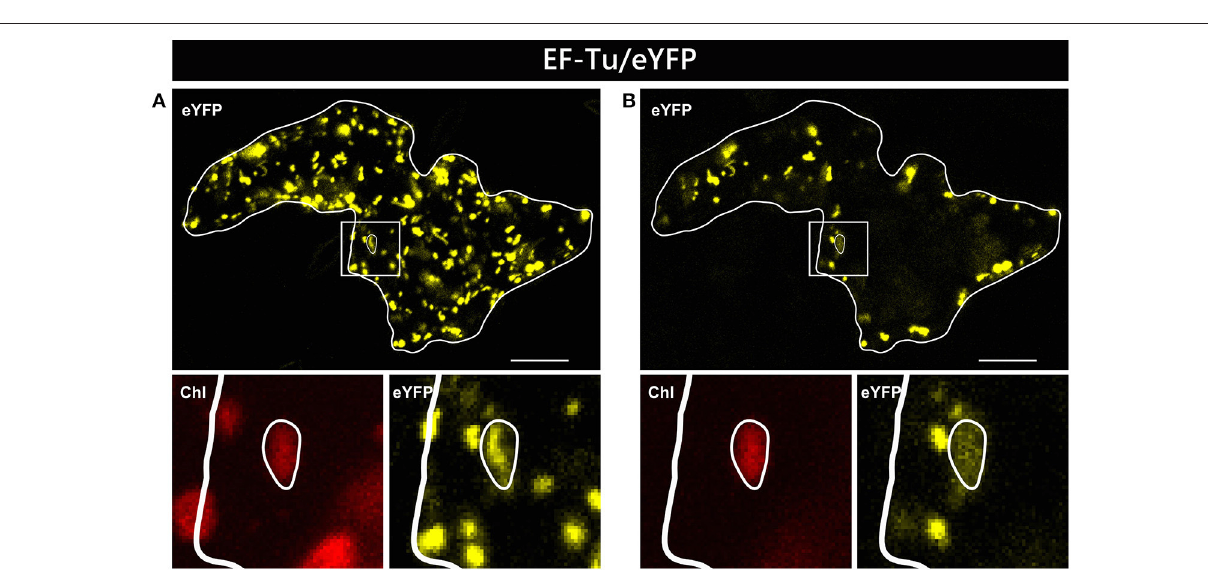
EF-Tu/eYFP showed reciprocal results, i.e., stronger fluorescence in mitochondria ( Supplementary Figures S3B, S4B ), in line with the results obtained after particle bombardment. For EF-Tu/eYFP, even exclusive mitochondrial localization was found in a few instances ( Table 1